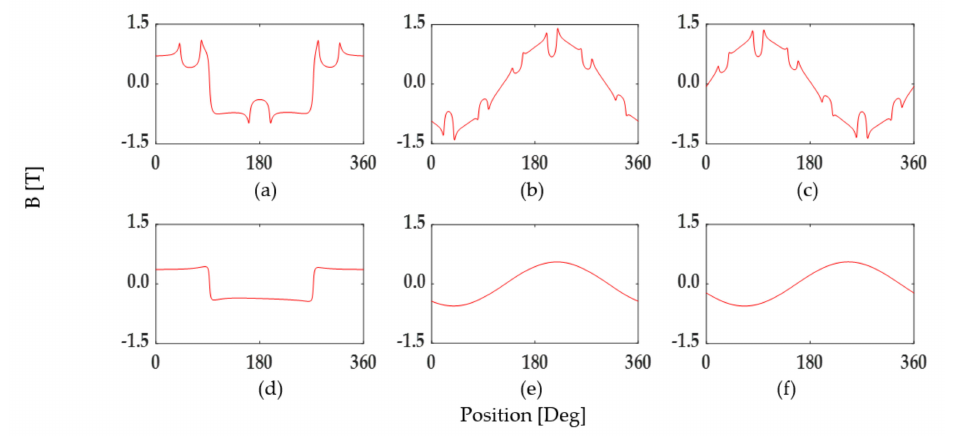
Figure 10. Distribution of armature flux density among six di ff erent PM motors: ( a ) 3Slot-1CS,